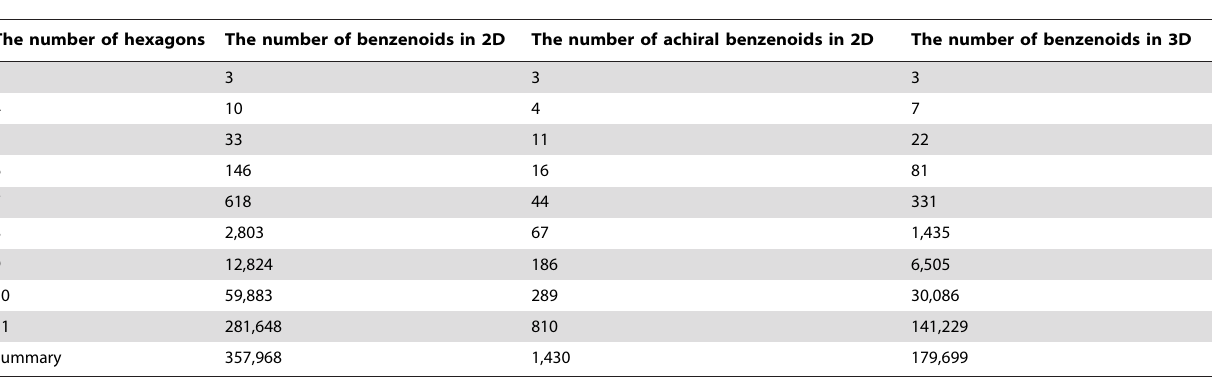
Table 2. The numbers of the achiral benzenoids and all the benzenoids in 2D space, and the number of benzenoids in 3D space.